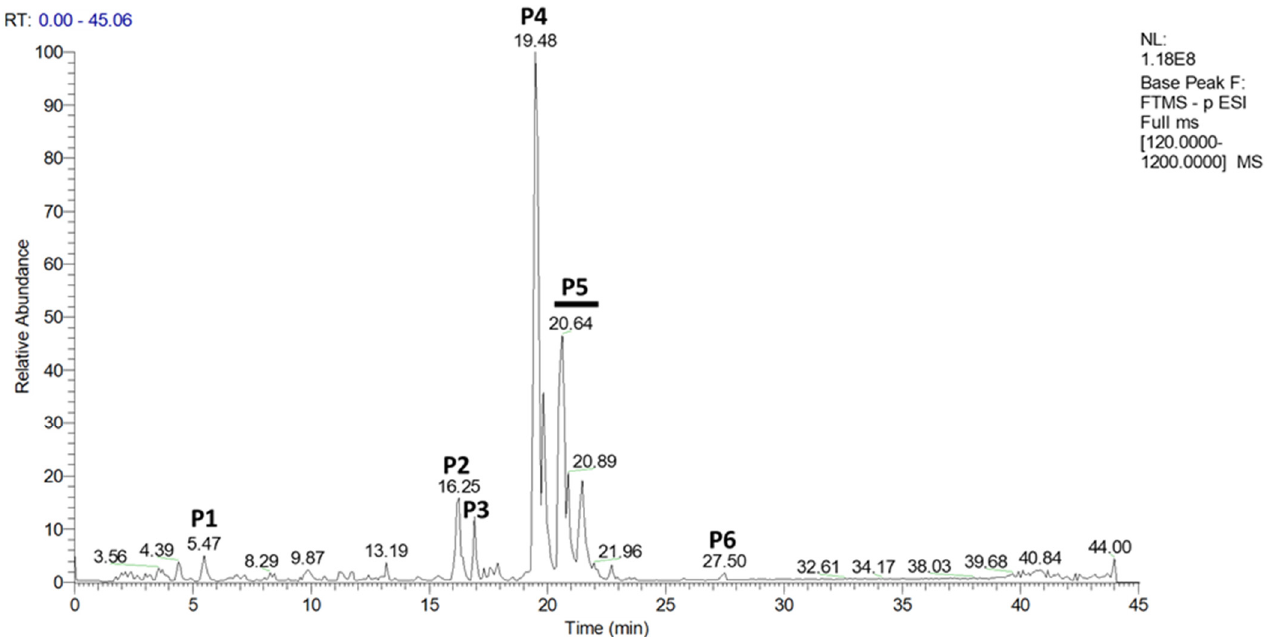
Figure 1. UHPLCMS chromatogram obtained from methanolic hop-leaf extract in negative mode. The molecular masses of the different products were characterized in negative mode. Their putative identifica- tions were made using the Compound Discoverer TM software (version 3.3). P1: m / z 367.1043 [M-H] − ,